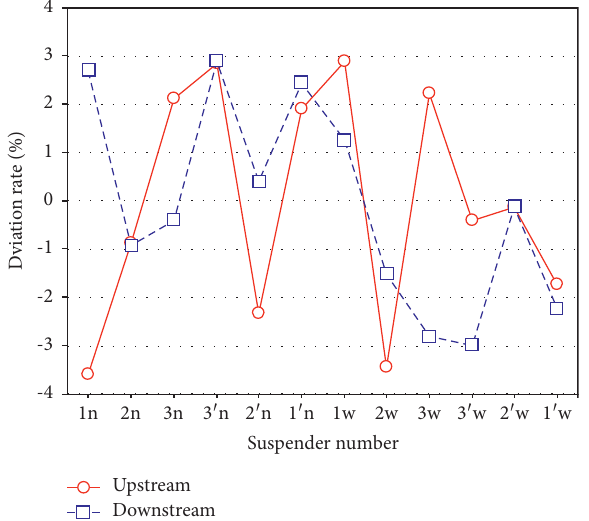
Figure 25: Deviation rate of short